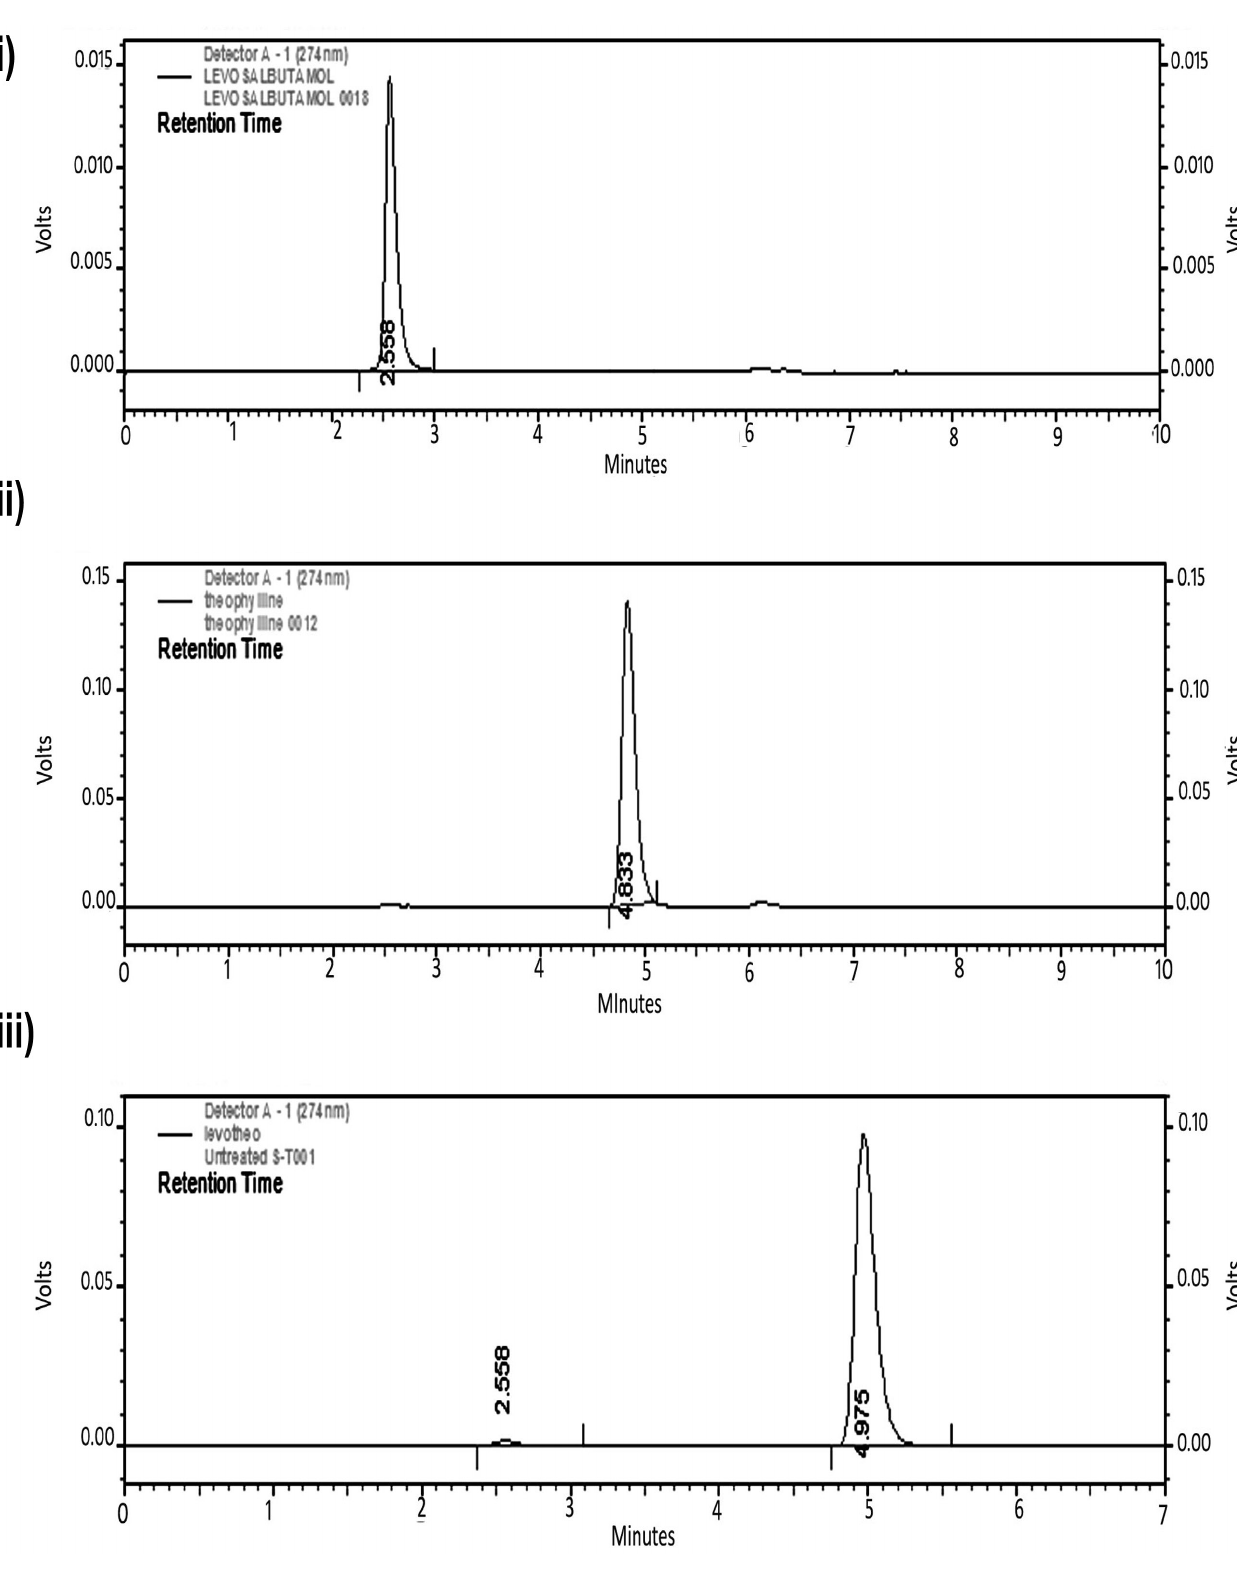
FIGURE 3A - Representative chromatograms of untreated drugs. Each chromatogram represents (i) levosalbutamol sulfate (1 μg. mL -1 ), (ii) theophylline (10 μg. mL -1 ), (iii) dosage form having levosalbutamol sulfate (1 μg. mL -1 ) and theophylline (10 μg. mL -1